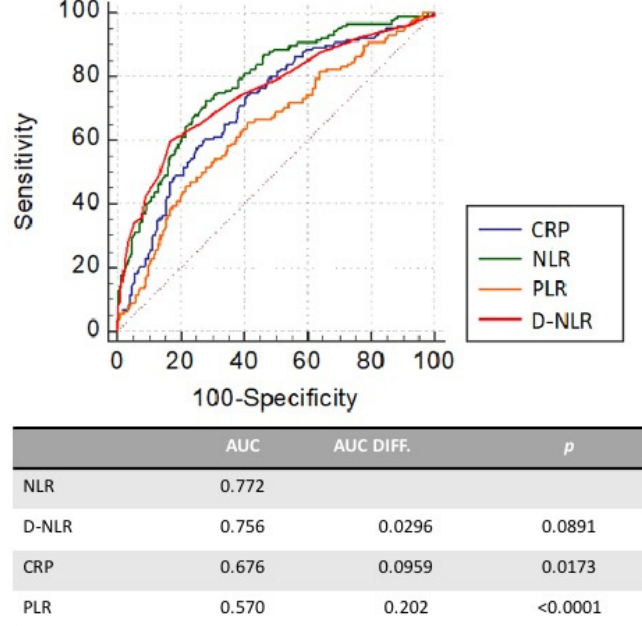
Figure 2. Receiver operating characteristic (ROC) curve of NLR, d-NLR, CRP, and PLR for predicting in-hospital mortality of COVID-19 patients.